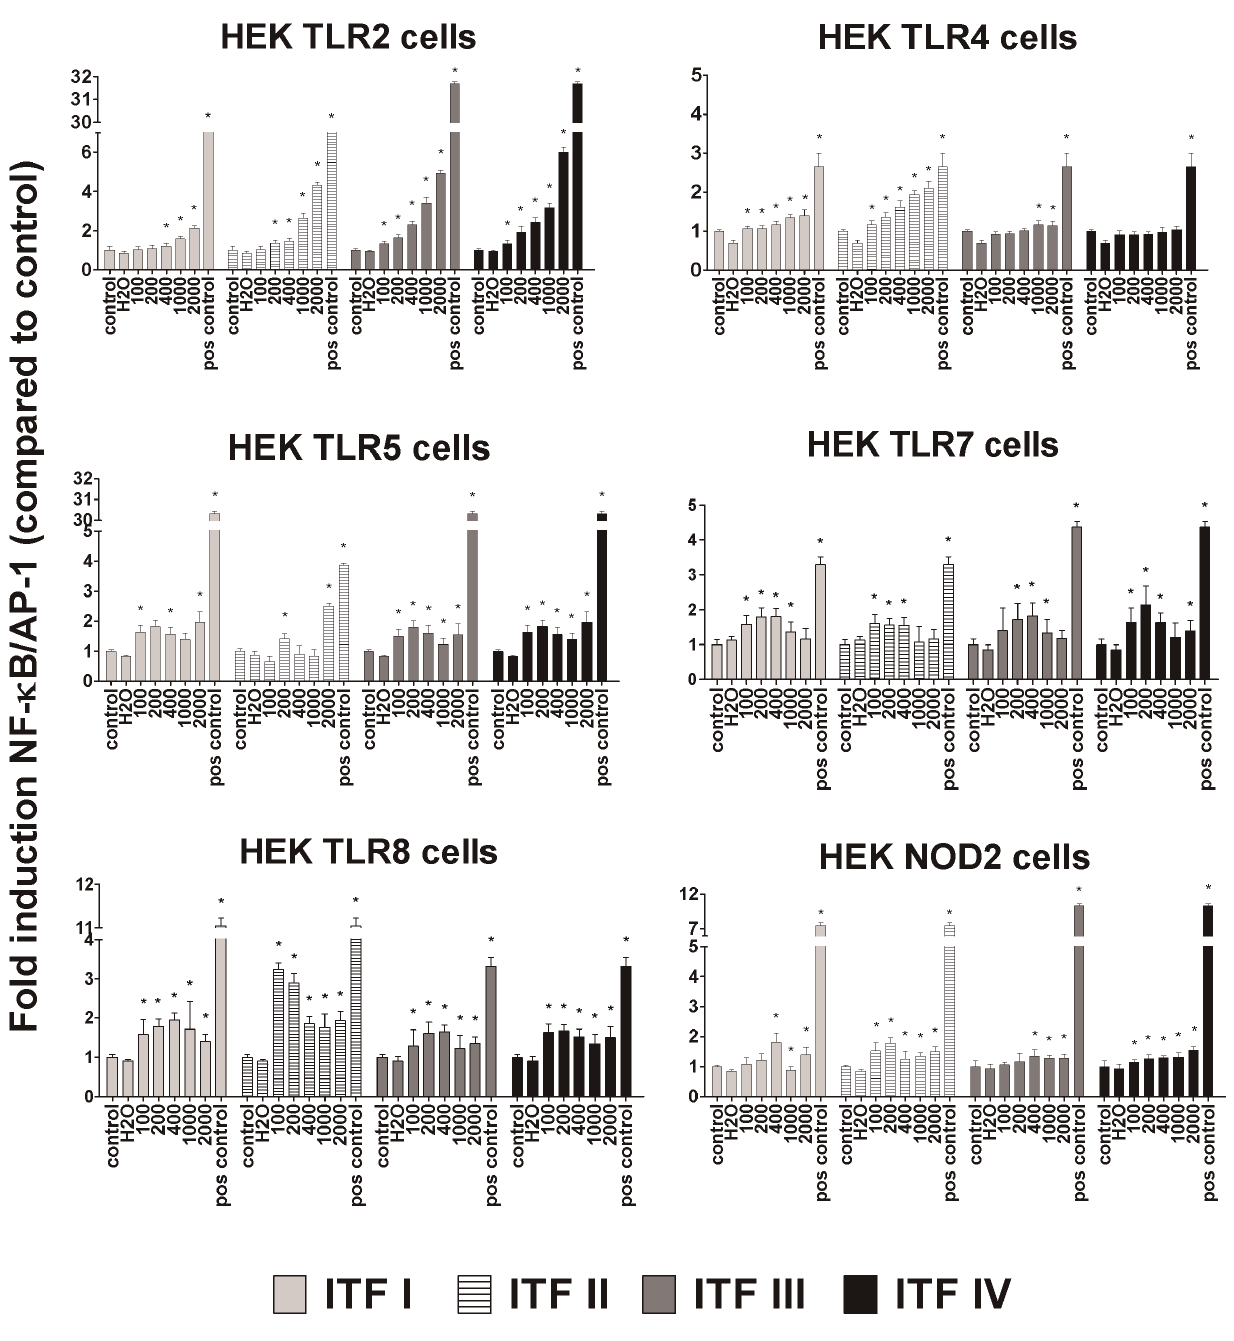
Figure 6. NF- k B/AP-1 activation of HEK cell lines overexpressing separate TLRs or NODs. Statistical significance levels were determined with a non-parametric Mann-Whitney U-test for unpaired observations (two-tailed). Mean and SD of NF- k B/AP-1 activation in HEK cell lines stimulated with b 2 R 1-fructans for 24 h are plotted as percentage of unstimulated controls, which were set to 100%. Dosages are plotted in m g/ml. Endotoxin free H 2 O was used as an additional negative control and per cell line the relevant positive controls were applied as mentioned in Table 1.